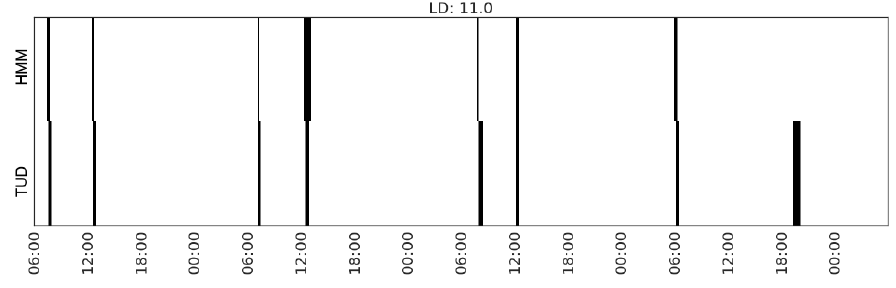
Figure 14. Recognising the activity of eating in Household 2 with feature set (MS_watts_kitchen-appliances, MS_range_living/dining-room(2)).